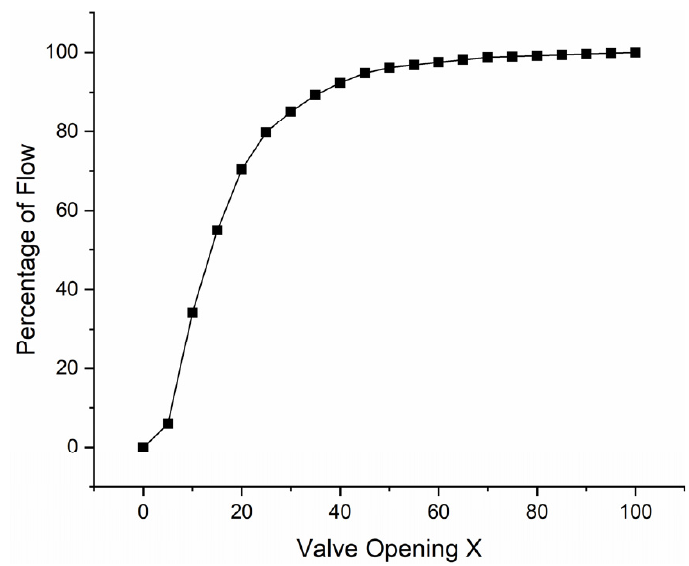
Figure 1. Governing stage of steam turbine unit.